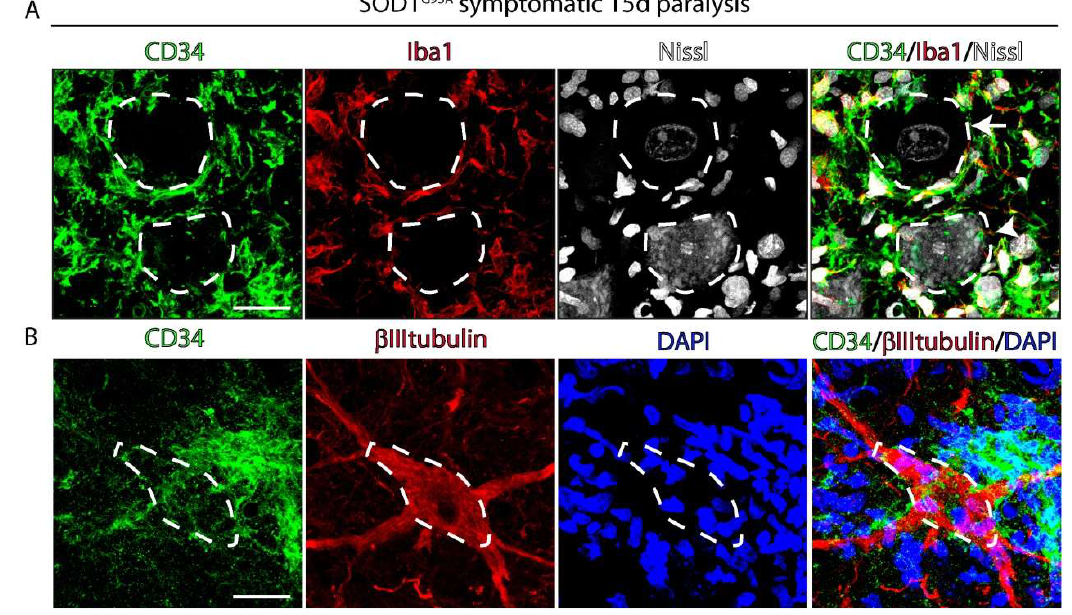
Figure 3. Spatial interaction of CD34 + cells with spinal motor neurons in symptomatic SOD1 G93A rats. Confocal microphotograph analyzing the association of CD34 + cells with motor neurons (dotted white lines) stained with Nissl ( A ) and β III-tubulin ( B ). Note that CD34 + / Iba1 + cells are adjacent to spinal motor neurons. Scale bars: 25 µ m.